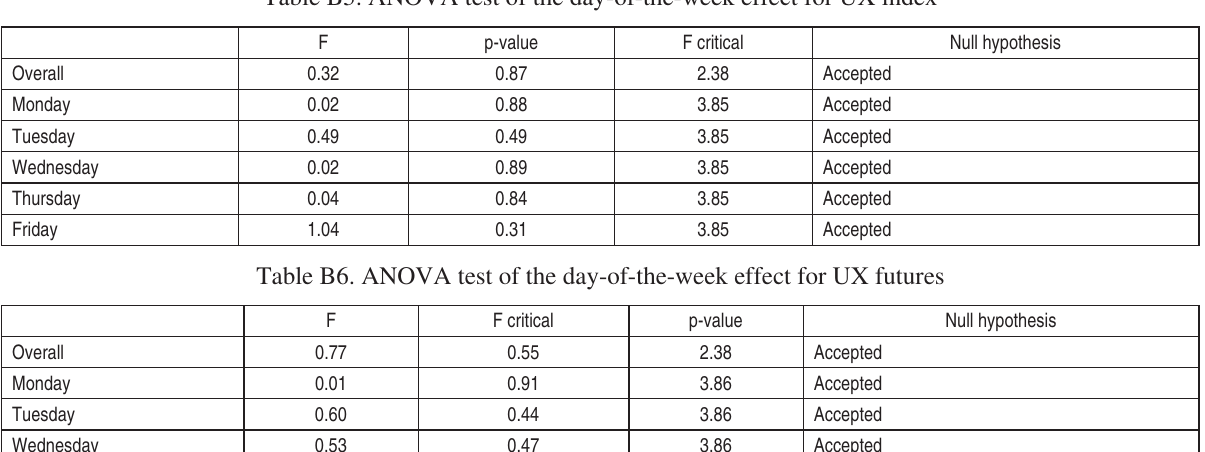
Table B5. ANOVA test of the day-of-the-week effect for UX index